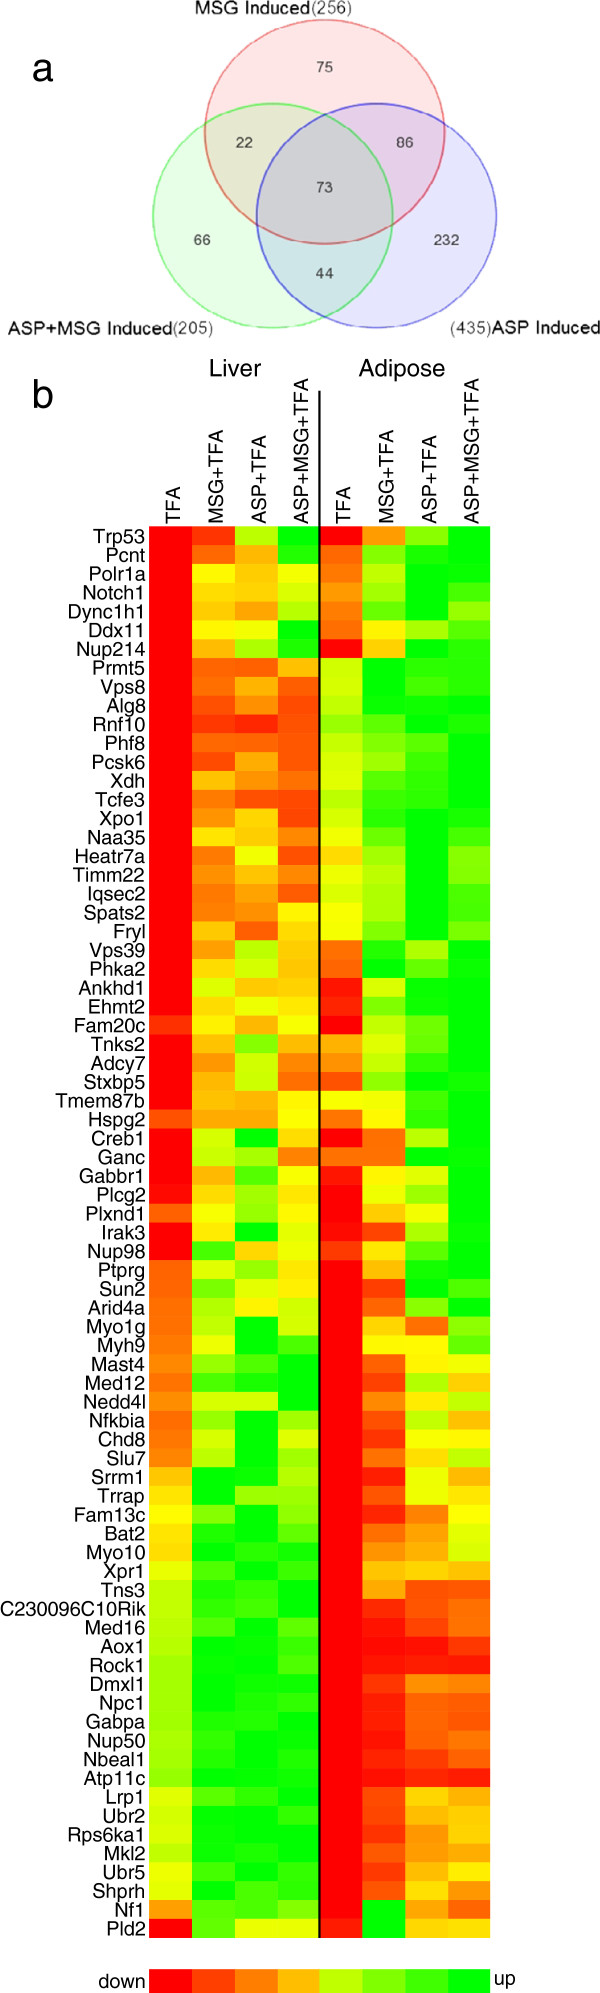
Upregulated gene expression shared by liver and adipose tissue. (a) Venn diagram displaying numbers of upregulated DEGs common to both liver and adipose tissue induced by either ASP, MSG or the combination of both additives. (b) 2-dimentional heat map of 73 upregulated DEGs common to both hepatic and adipose tissue (P < 0.05, stringency ≥ ± 1.4-fold change in expression).